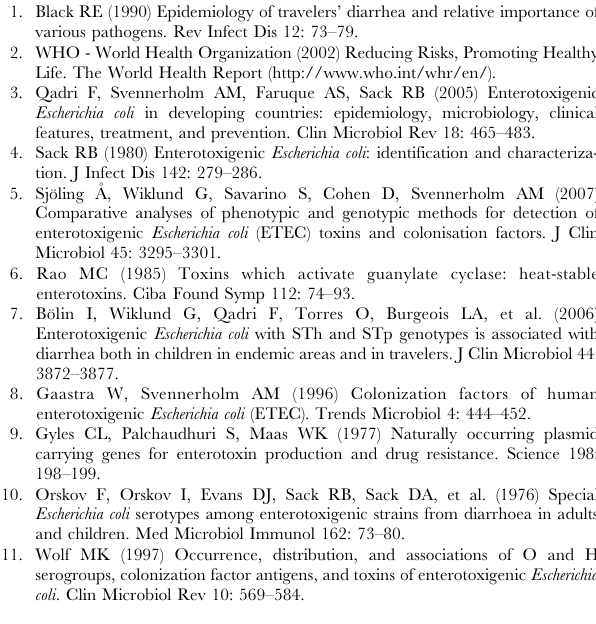
Table S1 Multi locus Sequence typing allele numbers of the strains included in the study. The alleles of the seven genes included in the Achtman E. coli scheme that designate the sequence type. New sequence types discovered were reported to the database and assigned new sequence type numbers. Clonal complexes includes related sequence types that differ from their nearest neighbour by no more than two of the seven